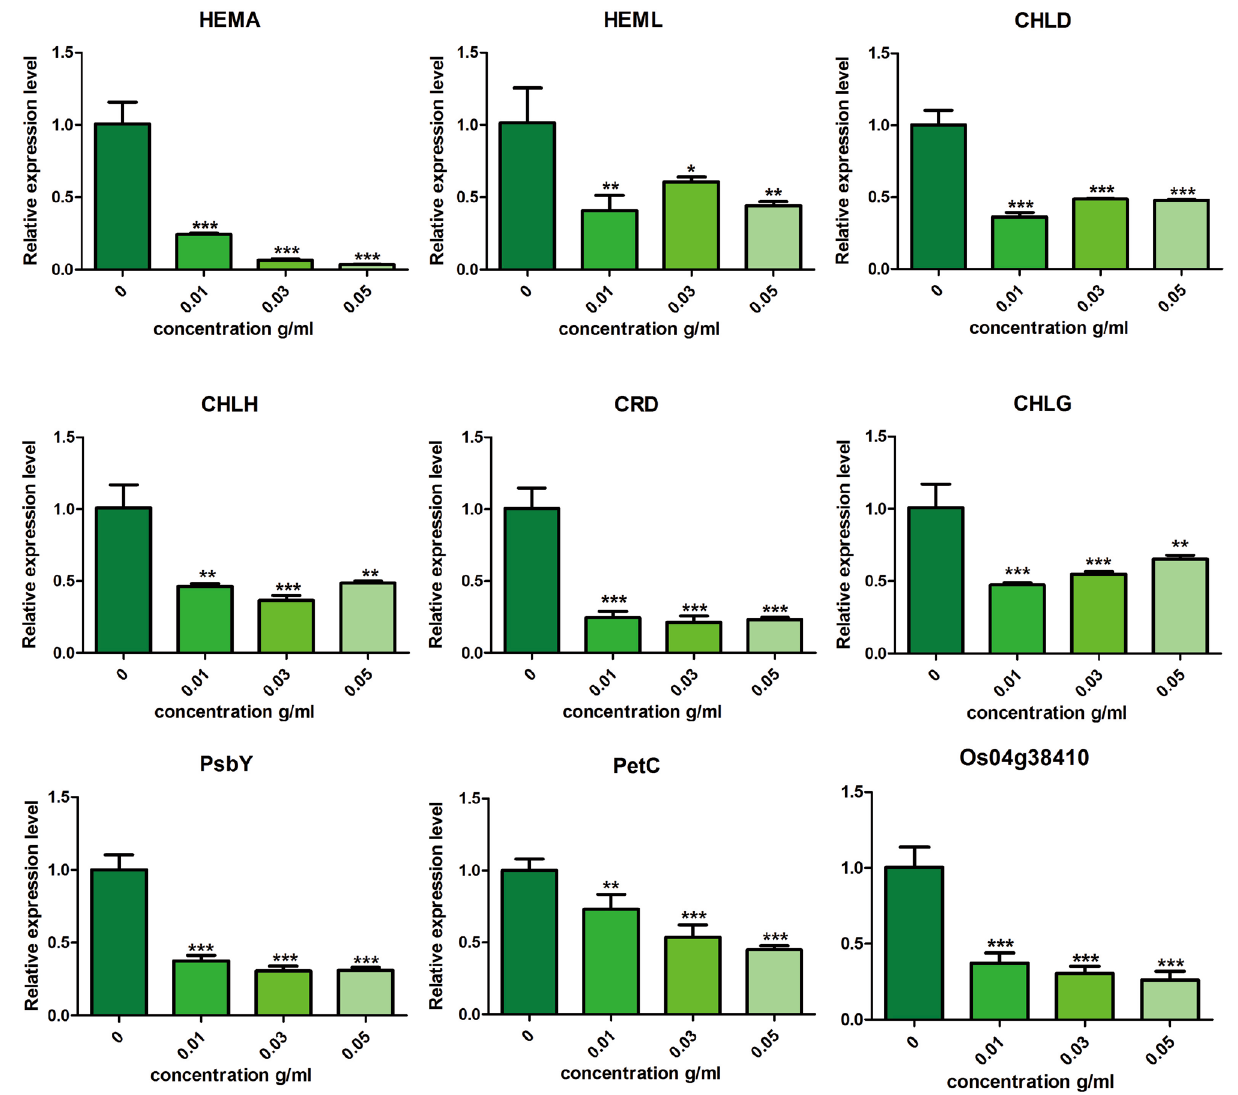
Figure 8. Expression of photosynthetic genes in O. sativa treated with different concentrations water-souble extact of